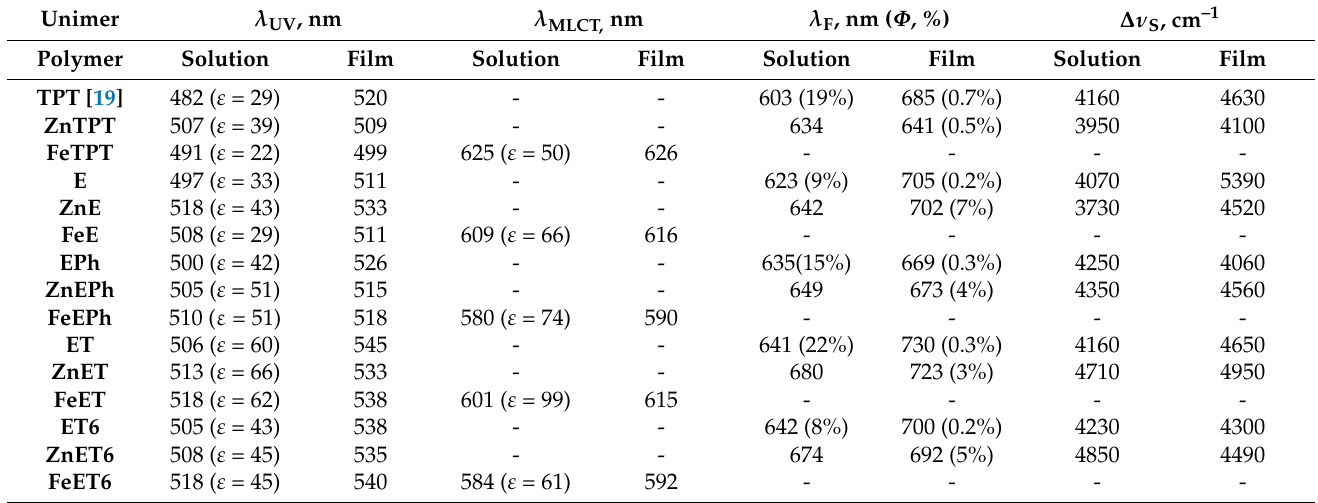
Table 1. Electronic spectral data of unimers and MSPs ( r = 1/1); λ UV , λ MLCT , and λ F are the wavelengths of maxima of the respective absorption and luminescence bands; ε is the molar absorption